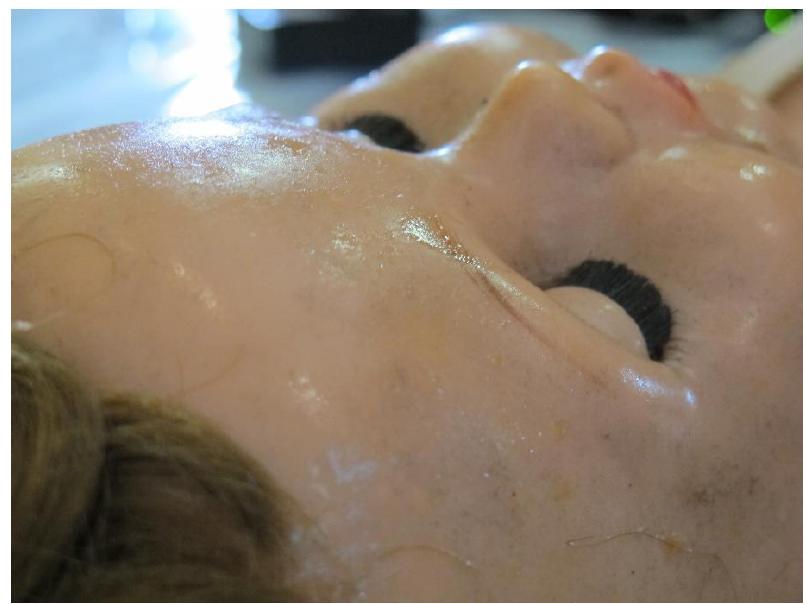
Figure 7. Plasticiser migration on PVC head of doll K2 (with CA body, arms and legs). A characteristic ‘sweaty’ surface with trapped surface dirt is visible. Image © Tate.